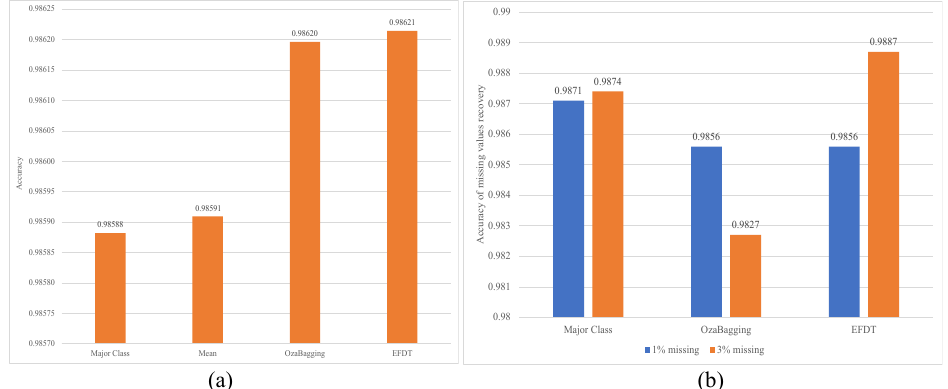
Figure 6. Comparison of Model performance with Model-besed imputation: ( a ) ARFC accuracy with 3% missing values; ( b ) Accuracy of missing value recovery with 1% and 3% ratios.